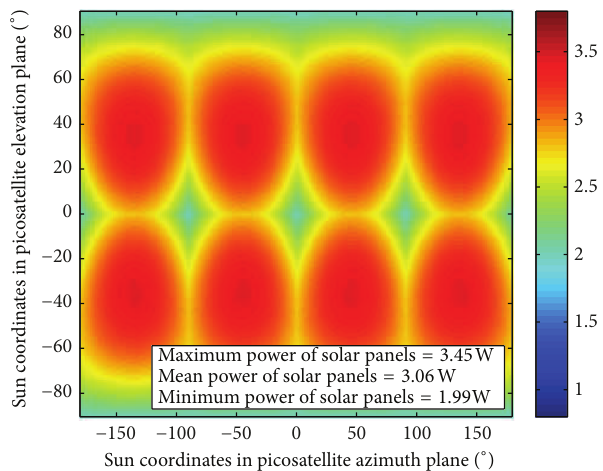
Figure 3: Power generation of gallium arsenide based solar panels placed on CubeSat walls in dependence on Sun position.